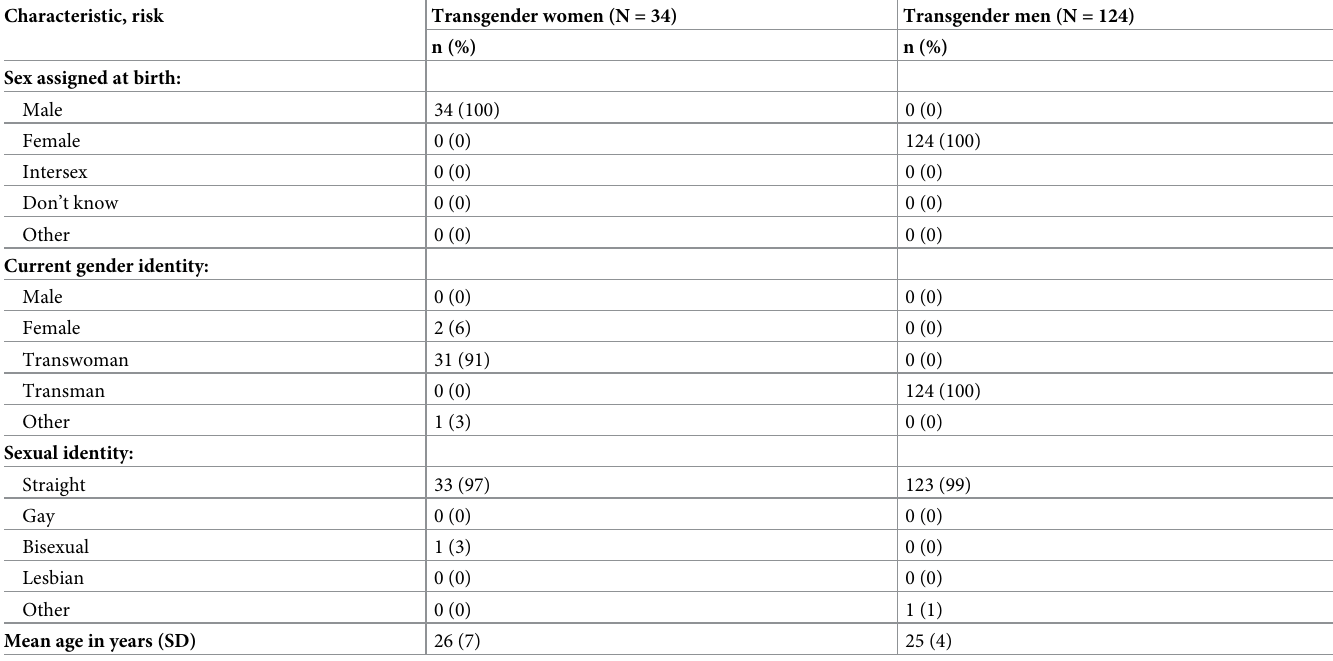
Table 1. Gender and sexual identities of transgender women and men, Bhutan, 2020. Characteristic, risk